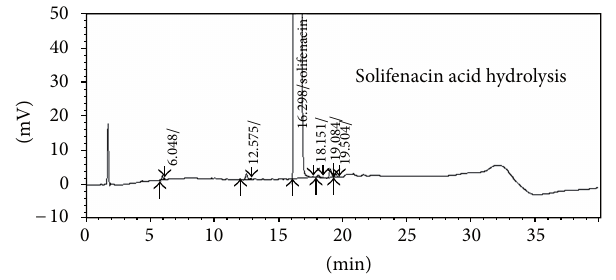
F 6: Typical HPLC chromatogram of 0.1NHCl stressed solution.